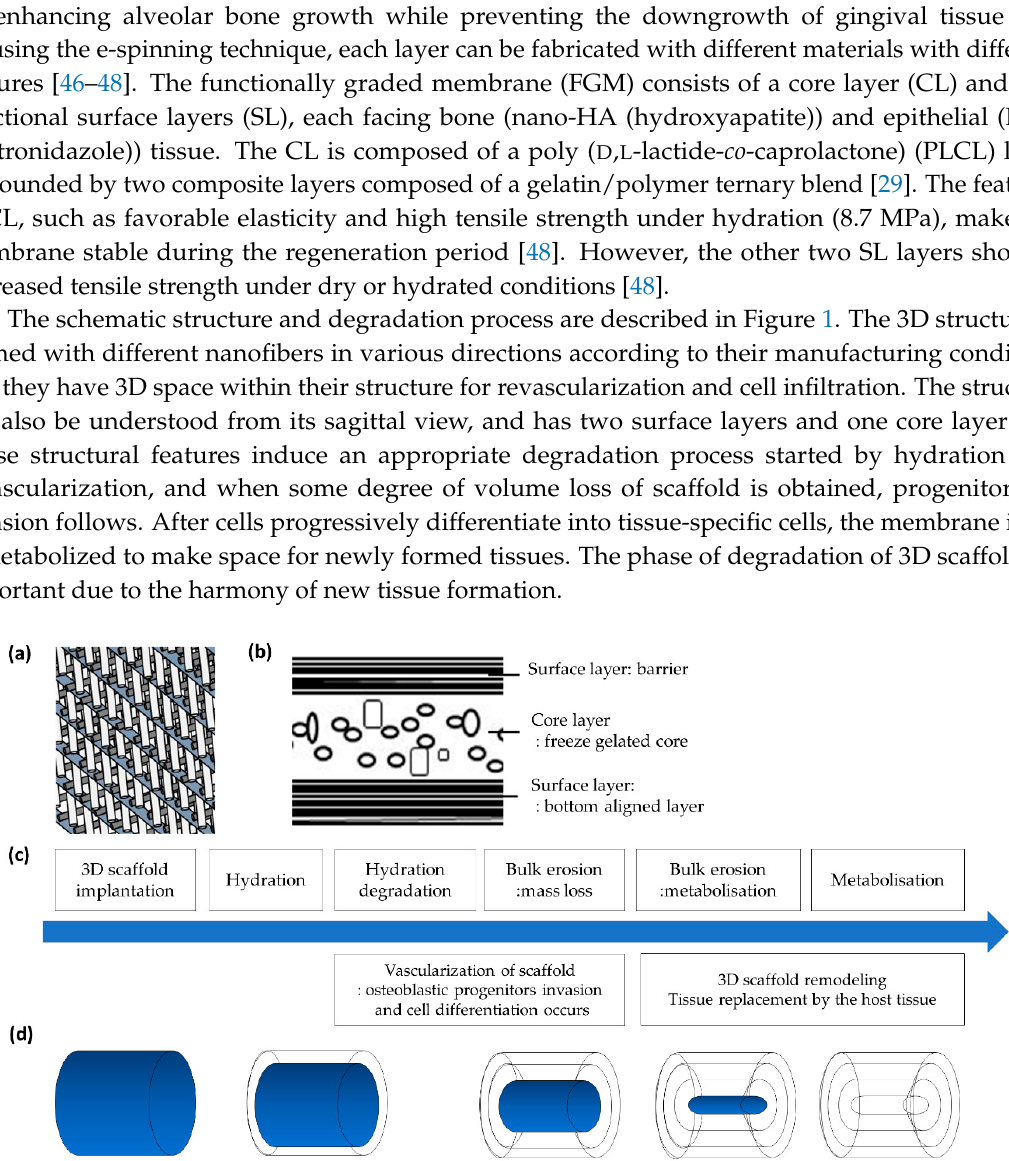
Figure 1. The schematic structure and degradation process of three-dimensional (3D) scaffolds. ( a ) Schematic structure of 3D scaffold with three different nanofibers; they form an inner space with a different biological feature for zone-dependent reaction during the regeneration period. ( b ) Sectional layers of a functionally graded membrane; two surface layers and one core layer with a different function are shown. ( c ) The degradation process of 3D scaffolds related to biologic reactions within a tissue. ( d ) The change of fibers consisting of a 3D structure according to the degradation procedure; space is not a hollow space but newly regenerated tissue.